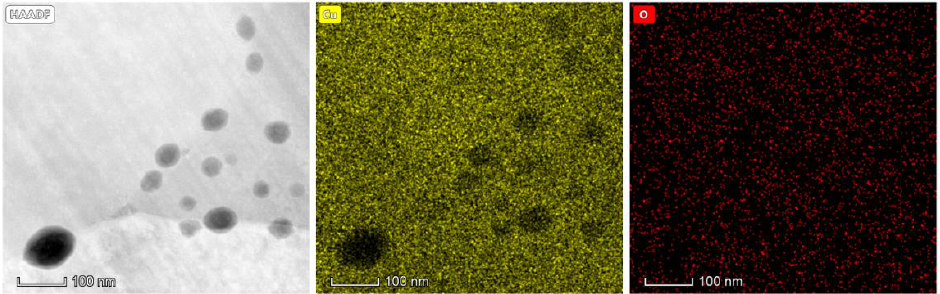
Figure 9. HAADF STEM micrograph and energy dispersive spectroscopy (EDS) of hydrogen-treated MO-Cu powder grain boundary triple point showing submicron scale H 2 O vapor induced porosity.